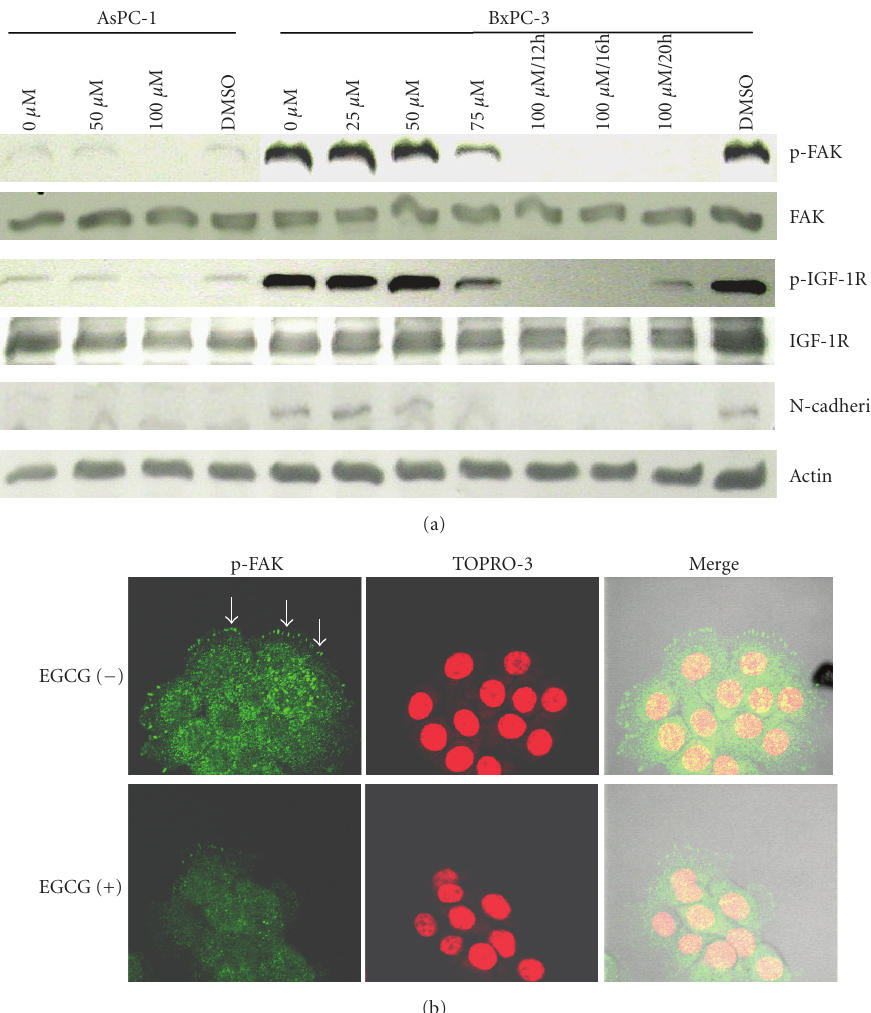
Figure 2: EGCG inhibits FAK activity. (a) Cells were plated at a density of 2 × 10 5 cells/ml in the presence of various concentrations of EGCG for 12 hours, except for BxPC-3 at 100 μ M for additional 4 or 8 hours. Total cell lysates were subjected to western blot analysis with indicated antibodies. Cells cultured in medium with 0.1% DMSO were used as a control. (b) Immunofluorescence staining for p-FAK (green) in BxPC-3 cells in the absence or presence of 100 μ M EGCG, as indicated. Expression of p-FAK (arrows) was significantly reduced in EGCG-treated cells as compared with control cells. Staining with TOPRO-3 (red) visualizes the nuclei.